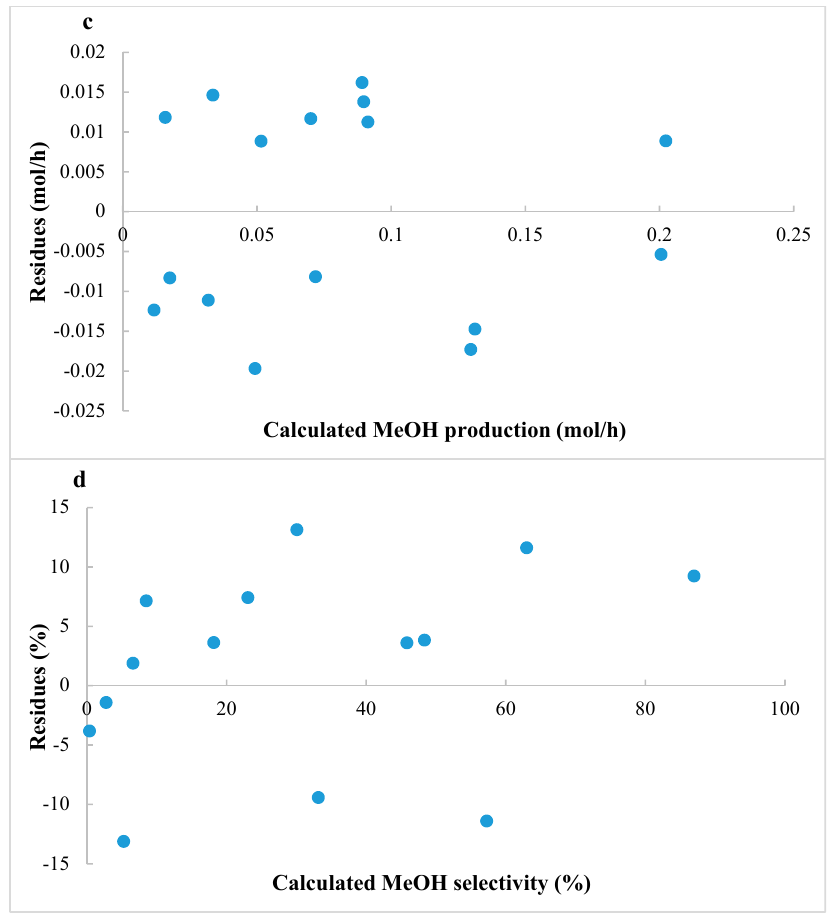
Figure 3. Trend of residues for ( a ) carbon conversion, ( b ) methanol yield, ( c ) methanol production, and ( d ) methanol selectivity.